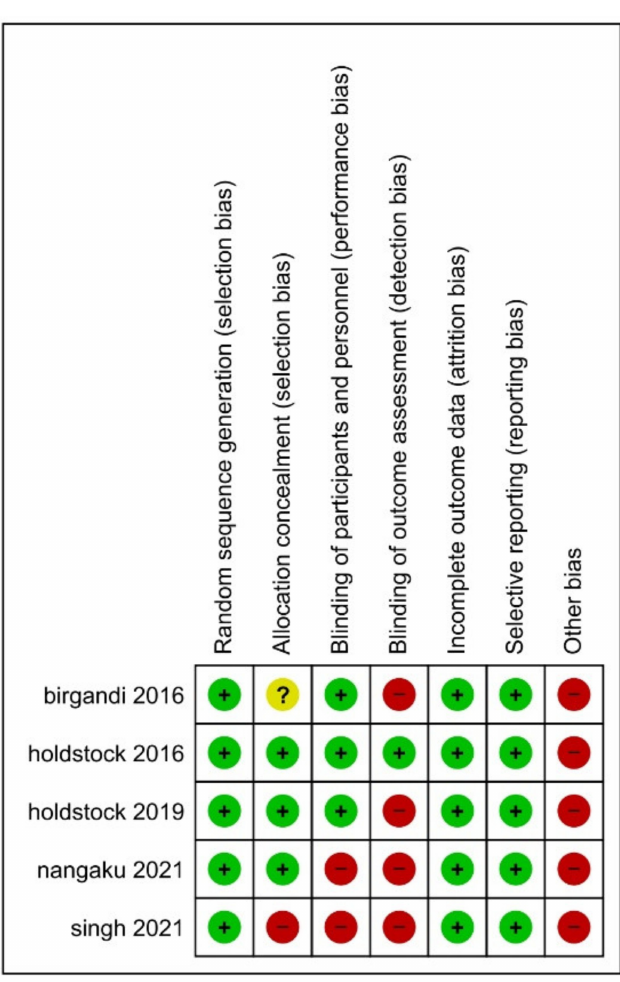
Figure 2. Risk of bias summary of the included